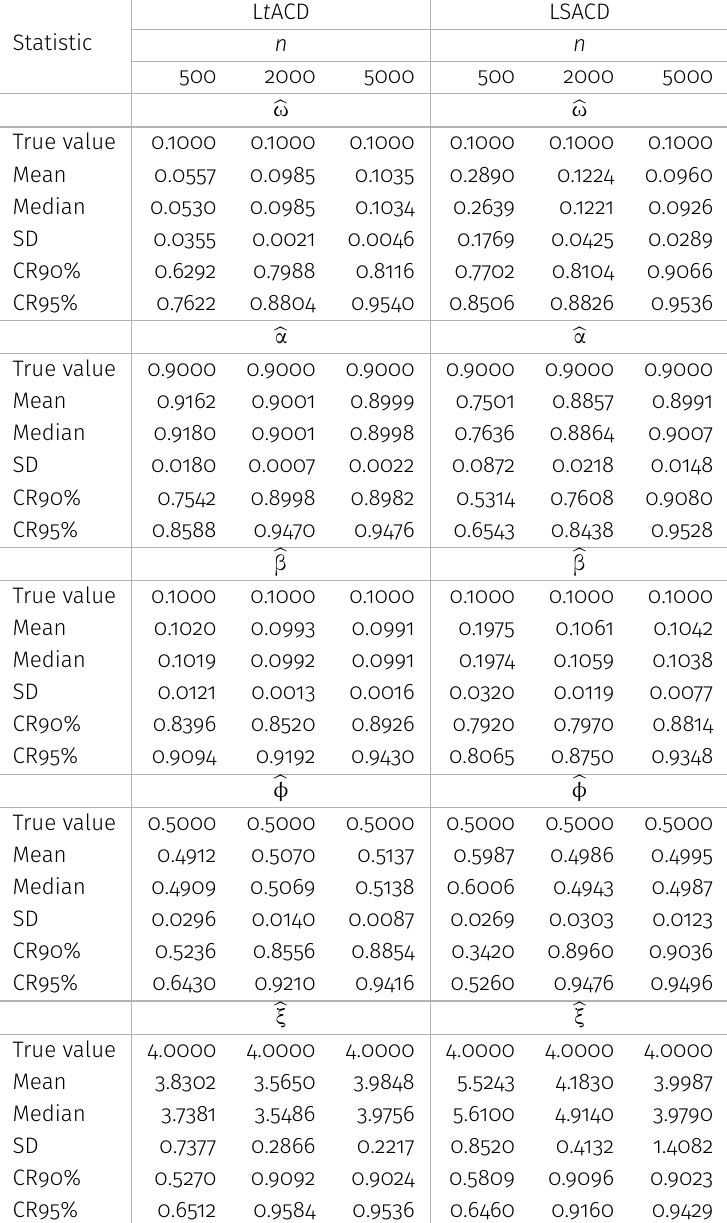
Table II. Summary statistics from simulated L ttt ACD and LSACD data for the indicated estimators and nnn .